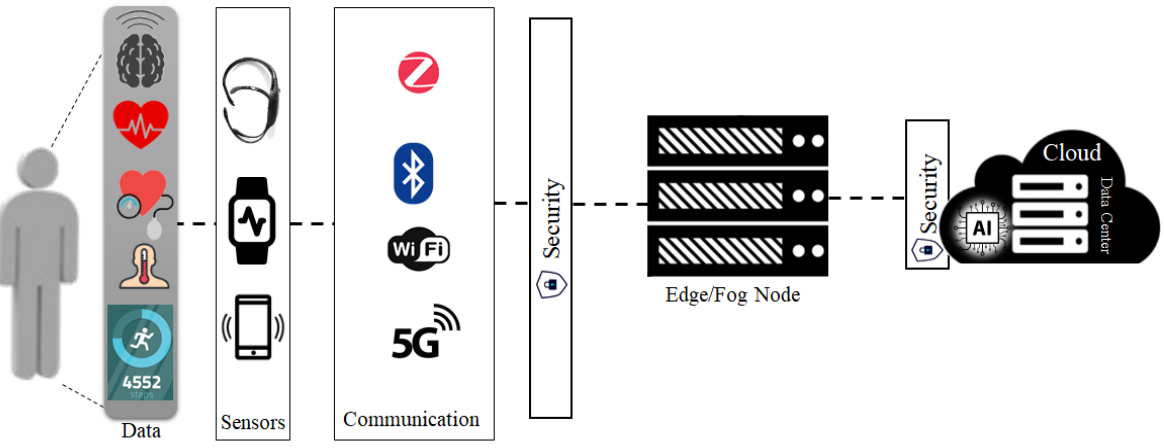
Figure 2. The key components in an H-IoT system, namely sensors, communication, AI, fog/edge/cloud computing, and security. Section 4 reviews these components in